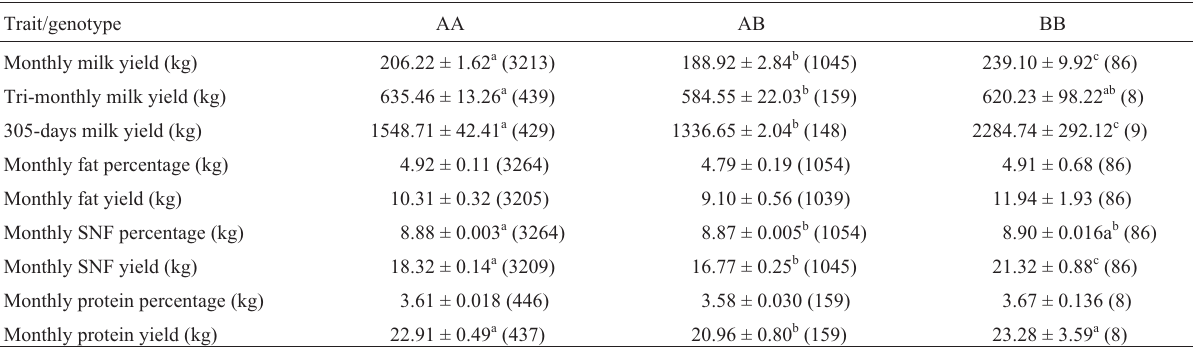
Table 2 - Least-squares means for κ -casein ( CSN3 ) genotypes of Sahiwal cattle. Trait/genotype